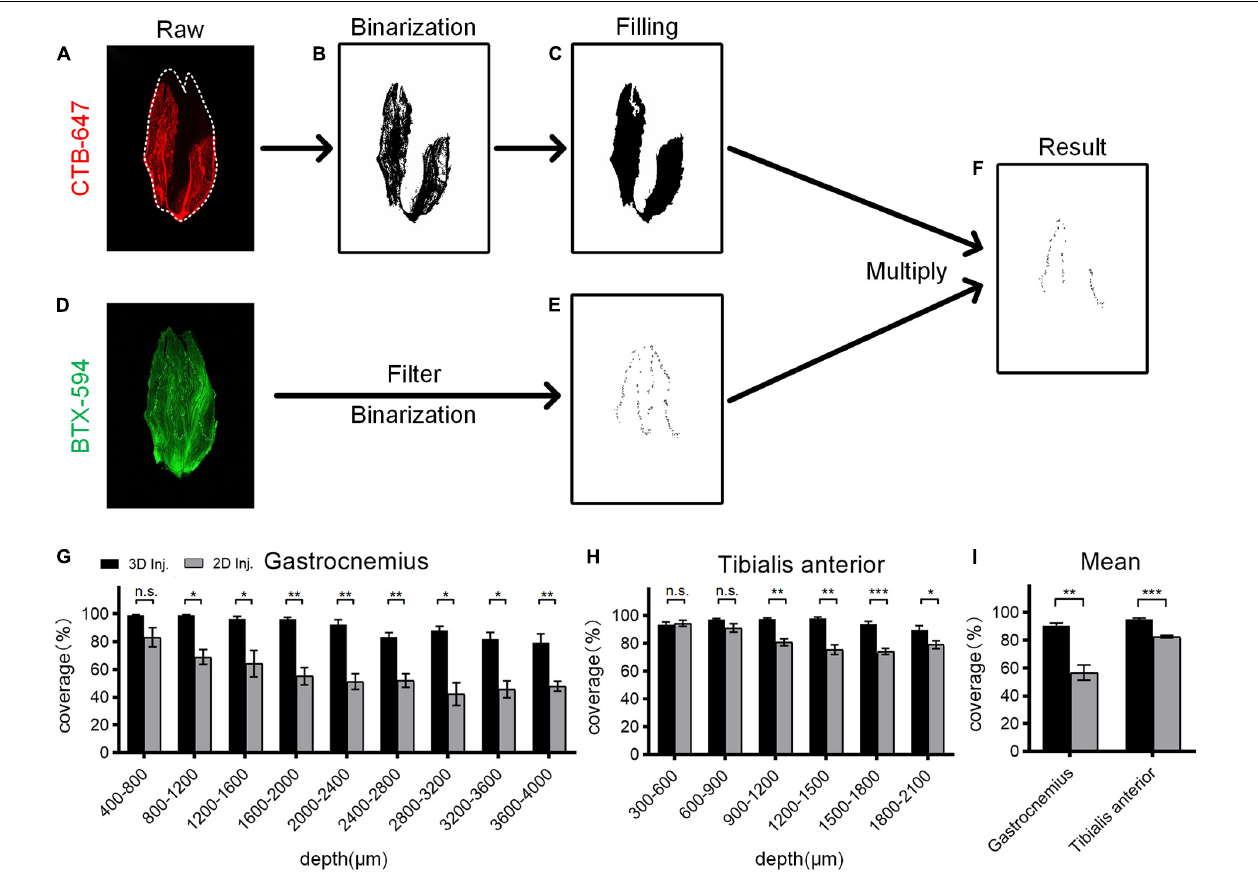
FIGURE 3 | Quantitative analysis of the coverage ratio between the cholera toxin subunit B (CTB) region and the motor endplate (MEP) distribution. (A) Raw fluorescence image of the CTB in the muscle section. (B) Segmentation of the CTB region by image binarization. (C) The binary image was processed by filling holes resulting from the heterogeneity of fluorescence signal to determine the CTB region. (D) Raw fluorescence image of the MEP distribution on the muscle section. (E) Segmentation of MEP distribution by image filtering and binarization. (F) The result by multiplying the binary images of the CTB region and MEP distribution. (G) Comparison of the coverage at different depths of the gastrocnemius after the 3D and 2D injections ( n = 4). (H) Comparison of the coverage at different depths of the tibialis anterior after the 3D and 2D injections ( n = 4). (I) The mean coverage of the gastrocnemius and tibialis anterior after two injection strategies. Data are presented as mean ± SEM. The statistical significance (n.s. represents no significance, * p < 0.05, ** p < 0.01, *** p < 0.001) in panels (G–I) was mainly assessed by independent-sample t -test. Some groups in panel (G) were assessed by the Mann–Whitney U -test or the separate variance estimation t -test due to the non-normal distribution or the heterogeneity of